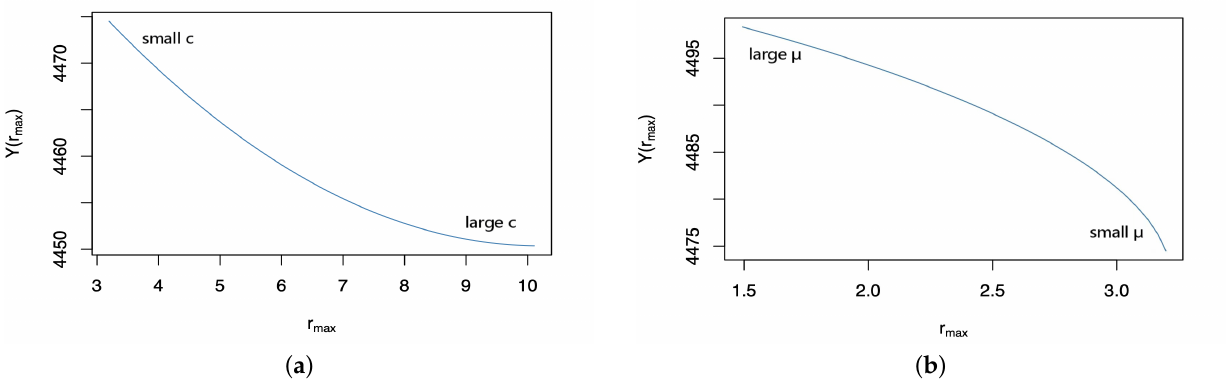
Figure 6. Effect of relocation-related parameters. ( a ) The maximum profit after implementing the relocation strategy with respect to the optimal relocation frequency under the influence of c ; ( b ) The maximum profit after implementing the relocation strategy with respect to the optimal relocation frequency under the influence of m